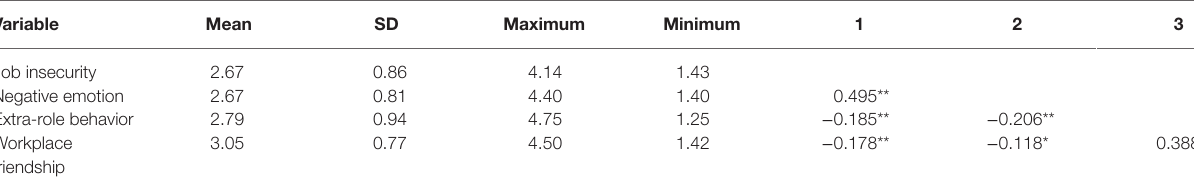
TABLE 2 | Descriptive statistical results and correlation coefficients. Variable